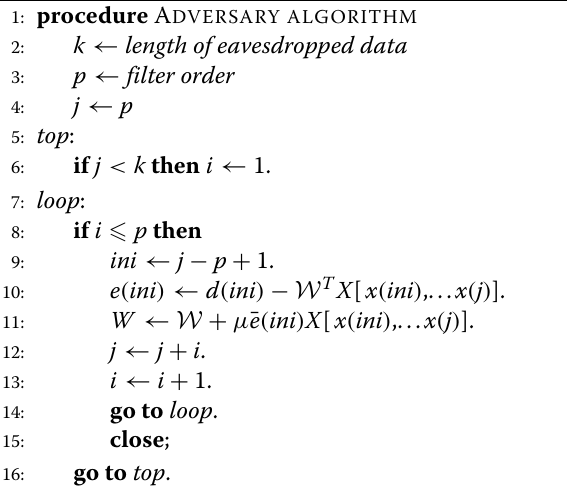
Algorithm 1 Non-parametric cyber-physical adversary